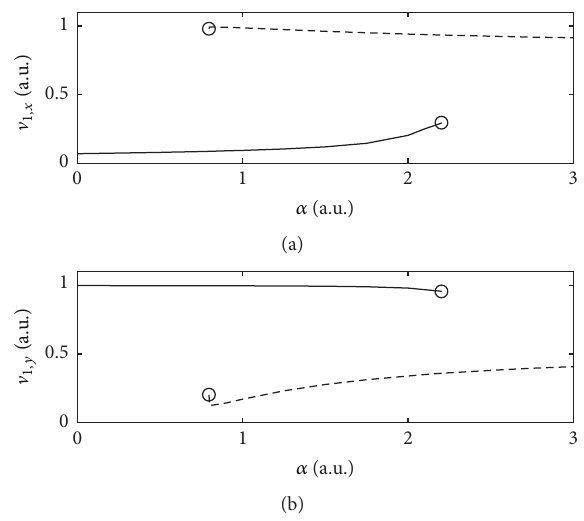
Figure 11: Eigenvector components of the first eigenvector and order parameters at the saddle-node bifurcation points. The eigen- vector components V 1,𝑥 (a) and V 1,𝑦 (b) as computed from (3) and (4) are shown for the state 𝑥 (low), 𝑦 (high) (solid line) and the state 𝑥 (high), 𝑦 (low) (dashed line) reported in Figure 5 and as functions of 𝛼 . At the saddle-node bifurcation points (circles), these components constitute the respective order